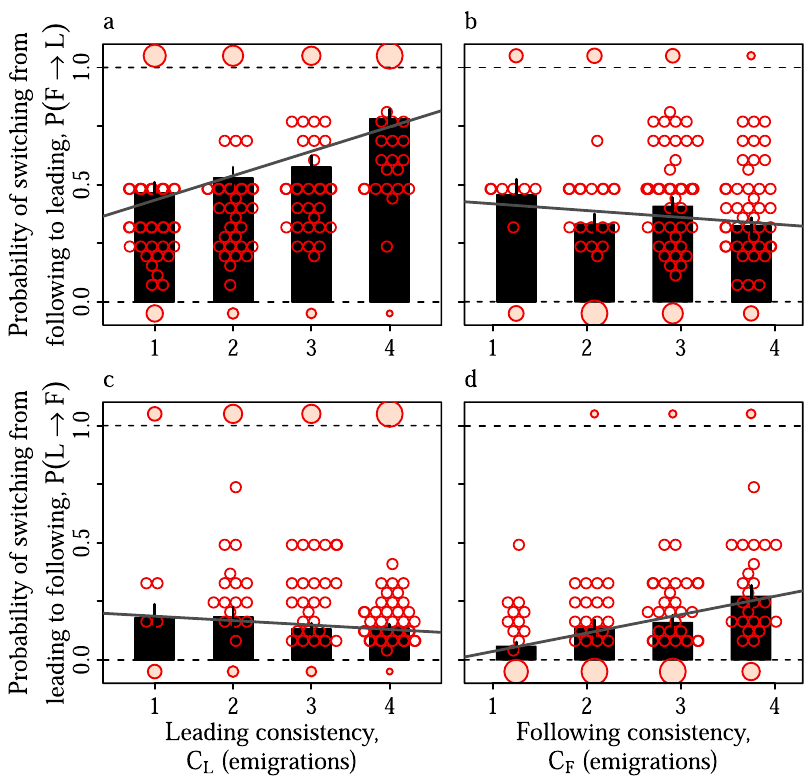
Fig. 2 Asymmetric switching between leading and following. Bars and errors represent the mean and standard error of the per-tandem switching probabilities, averaged across all individuals with a given leading or following consistency. a , b Per-tandem probability that an ant acting as a follower in a given tandem switches to leading in the next tandem. c , d Per-tandem probability that an ant acting as a leader in a given tandem switches to following in the next tandem. Grey lines show the LMM fi ts mentioned in the text. Empty points represents the per-tandem switching probability for a single individual. Filled points represent individuals with switching probabilities of zero or one. The diameters of the fi lled points are proportional to the number of ants that had a switching probability of zero or